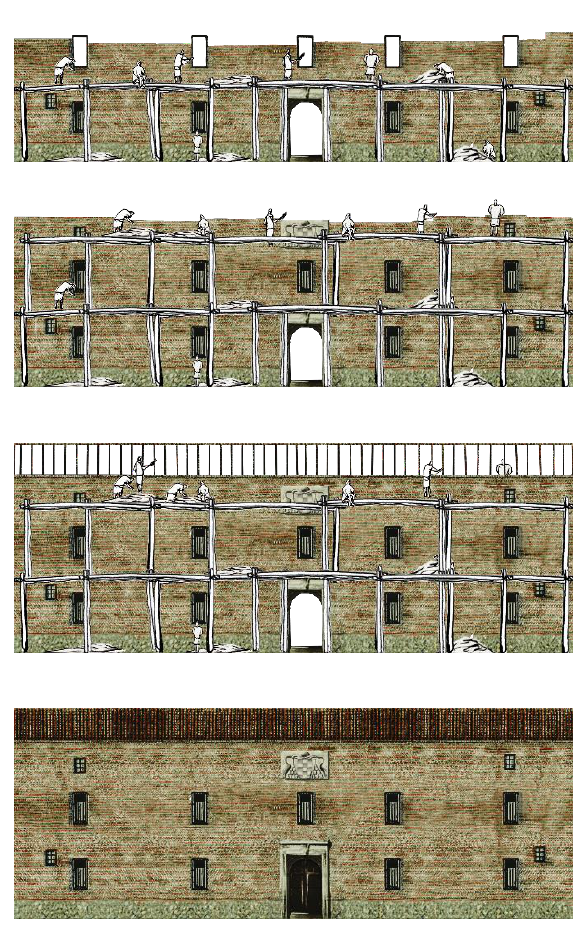
Figure 4. AR Drawings. Process of construction of the façade University of